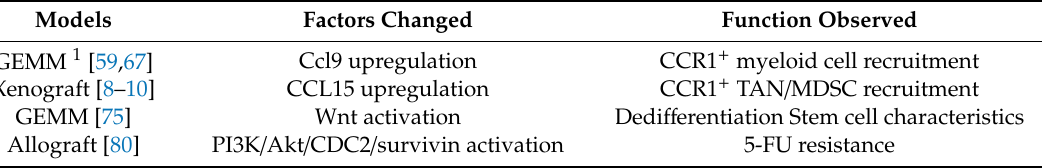
Table 1. SMAD4 loss-induced changes in vivo (animal models).